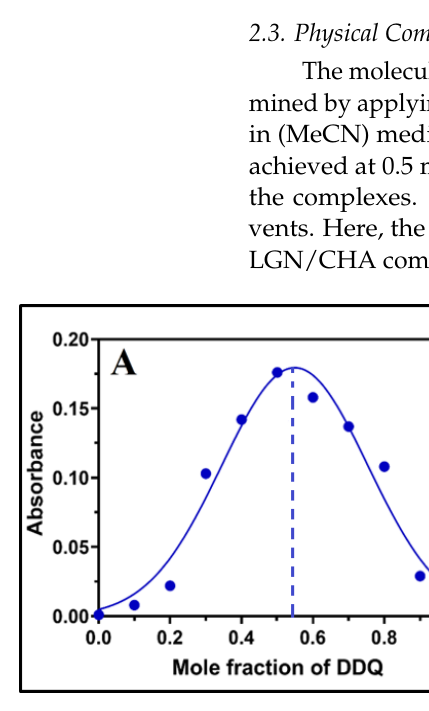
Figure 4. Electronic absorption spectra of ( A ) blue line for LGN (1 × 10 – 4 M), red line for DDQ 1 × 10 – 4 M and complex with black line of LGN-DDQ (1:1); ( B ) blue line for LGN (1 × 10 – 4 M), red line for CHA 1 × 10 – 4 M and complex with black line of LGN-CHA (1:1) complex (1 × 10 – 4 M + 1 × 10 – 4 M) in MeCN at room temperature.